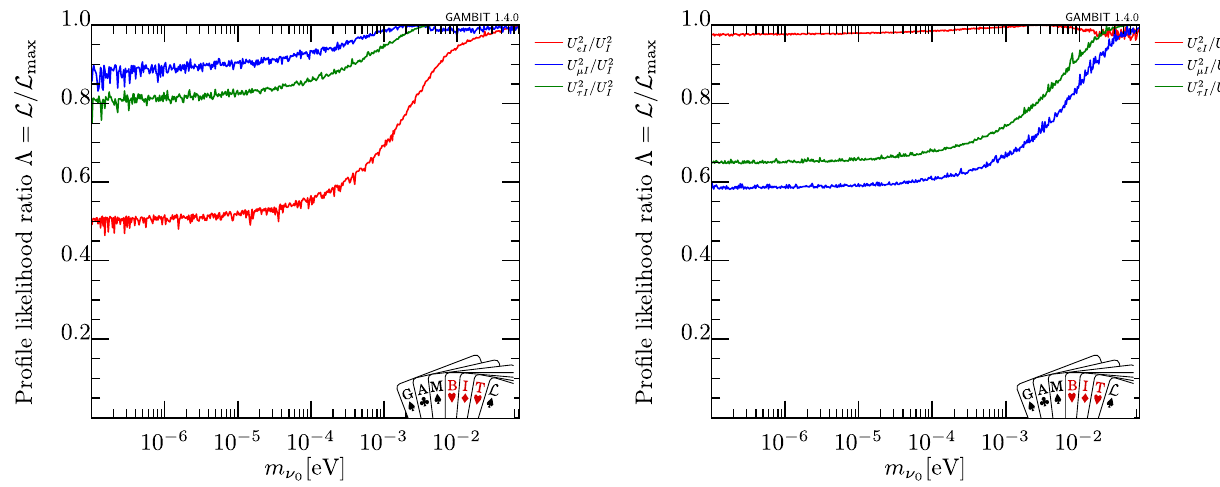
/ U 2 within 2 σ as a function of the lightest active neutrino mass m ν I I